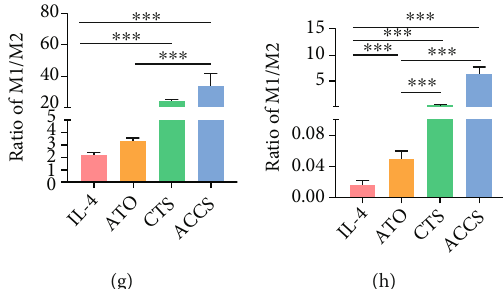
Figure 4: (a) The e ff ect of ACCS on the polarization of primary macrophages. (b) The proportion of M1. (c) The proportion of M2. (d) Tumor-like M2 macrophage model induced by IL-4. (e) The proportion of M1. (f) The proportion of M2. (g) The ratio of M1/M2 in normal group. (h) The ratio of M1/M2 in IL-4-induced